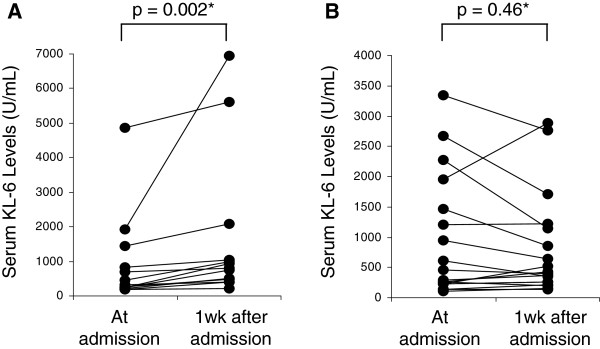
Serial changes in serum KL-6 levels at admission and one week after admission. (A) Patients who showed a decrease in PaO2/FIO2 ratio during the initial week (n=13). (B) Patients who showed an increase in oxygenation index during the initial week (n=16).